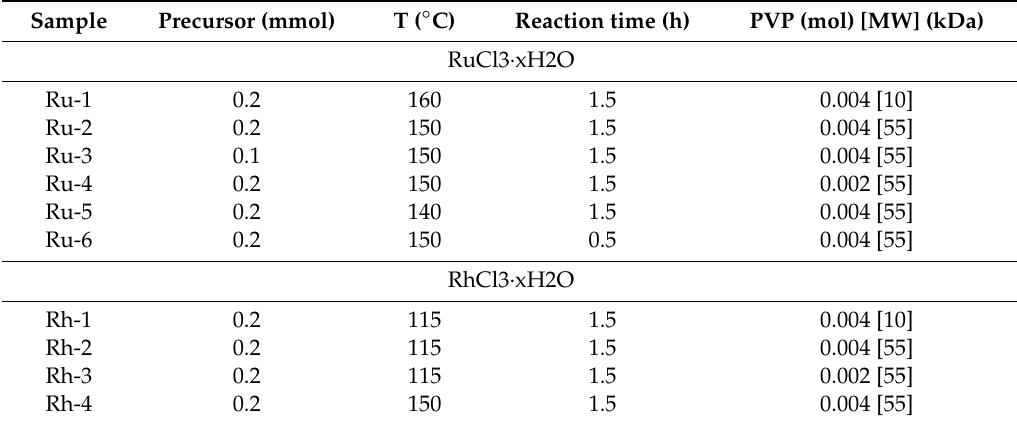
Table 1. Synthesis conditions for Ru and Rh NPs by polyol method: amount of precursor, reaction temperature, reaction time, amount and molecular weight of PVP are specified for each